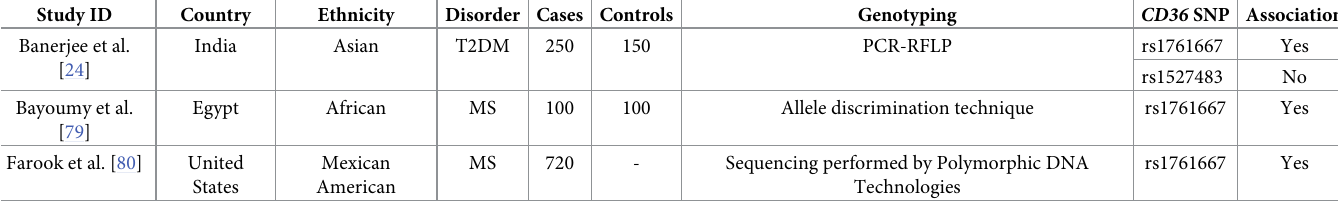
Table 12. List of studies that have investigated the association of CD36 polymorphisms (rs1761667 and rs1527483) with T2DM and MS. Study